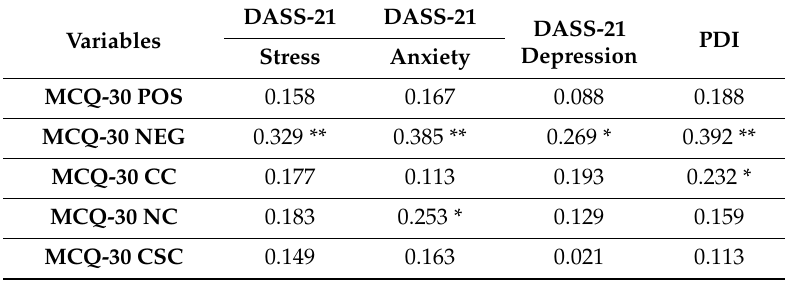
Table 4. Pearson r correlations between MCQ-30, DASS-21, and PDI scores for the